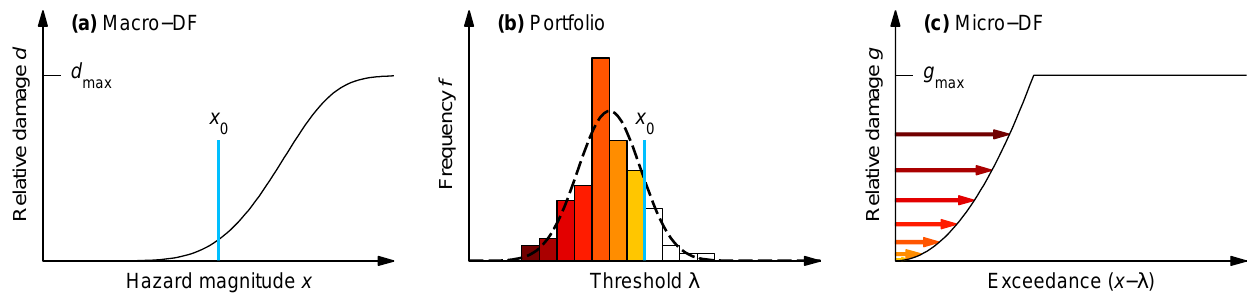
Figure 2. Schematically, (a) shows a macroscale damage function based on a building portfolio with a distribution of hazard thresholds as shown in (b) , where coloured bars indicate portfolio segments affected at hazard magnitude x 0 . (c) shows the applied microscale damage function. Accordingly, the coloured arrows indicate the damage inflicted on the respective portfolio segments at x 0